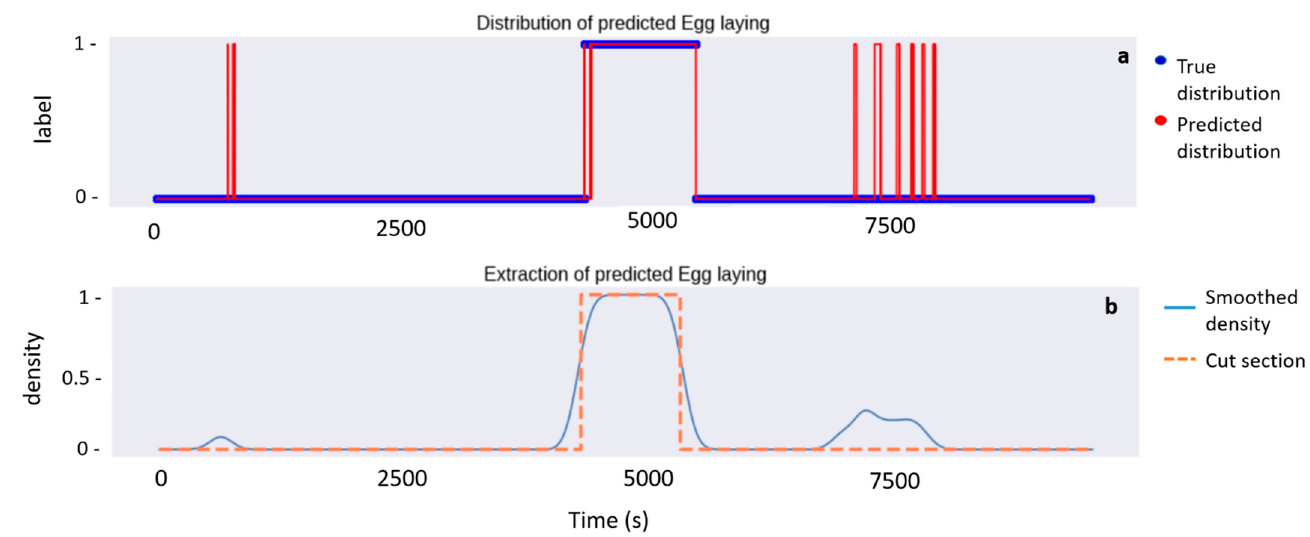
Figure 3. Representation of each step of the extraction of the Egg laying period from the predictions of the V-net for the individual #11. The first panel (a) shows the true distribution of Eff Laying over time compared to the predicted distribution by the V-net. The second panel (b) shows the smoothed signal of the predicted distribution while the orange dashed line represents the automatically extracted Egg Laying period from which the number of eggs laid is estimated.